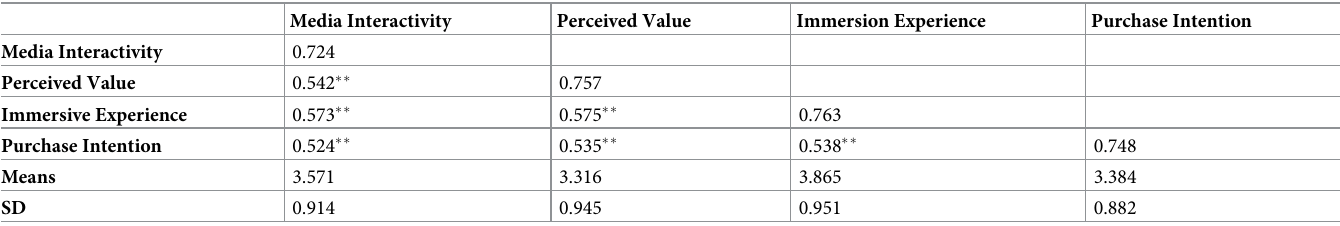
Table 2. Descriptive statistics and reliability test of all items.